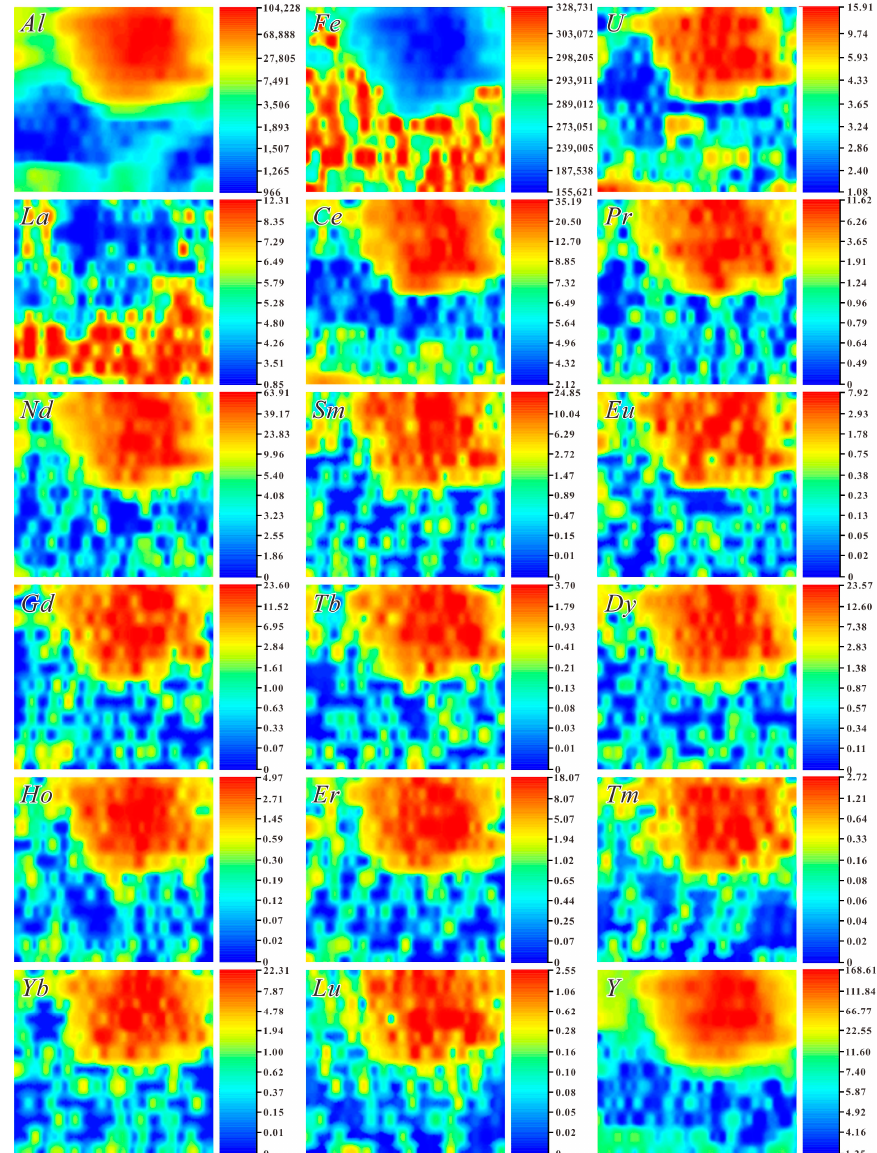
Figure 5. LA-ICP-MS trace element maps of the Xinqiao garnet; all maps show ppm abundances on a log